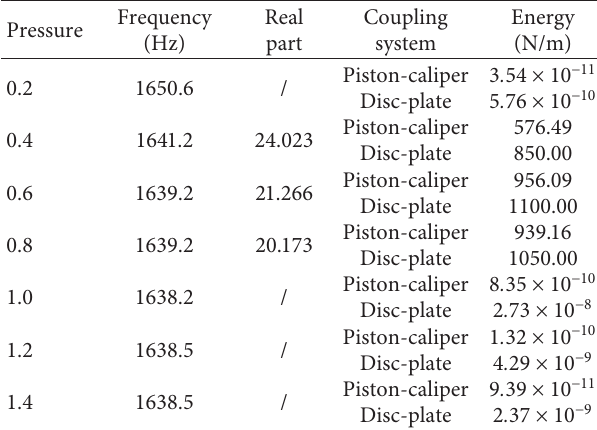
Figure 6: Vibration mode shapes at the complex characteristic frequencies. Table 3: Feed-in energy of the dual coupling subsystem near 1600Hz.